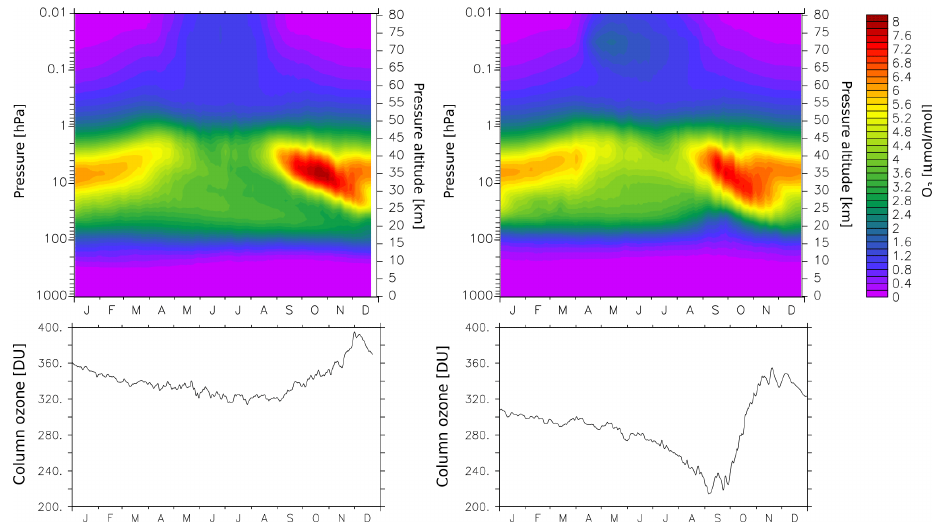
Figure 5. Top panel: zonal mean ozone (µmolmol − 1 ) averaged between 60 and 90 ◦ S for the year 2000 from the maCMAC-FV (left) and maEMAC (right) simulations. Bottom panel: column ozone for the same